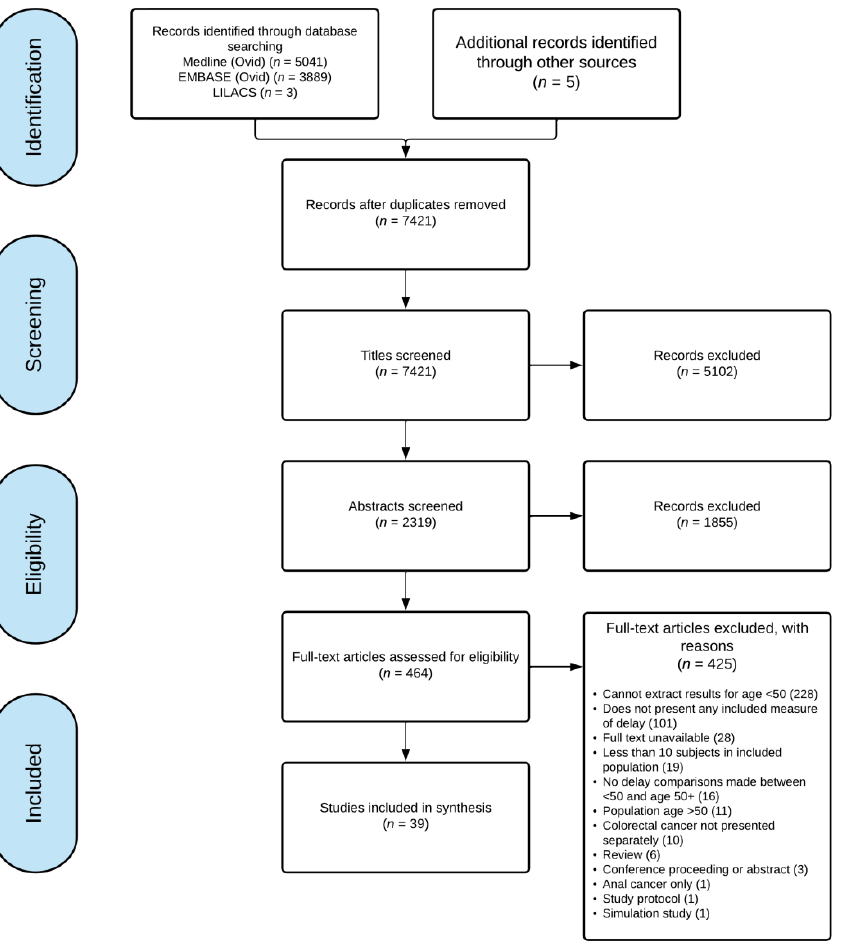
Figure 1. Preferred Reporting Items for Systematic Review and Meta-analysis flow diagram of included studies. Values indicate the number of studies meeting that criteria.